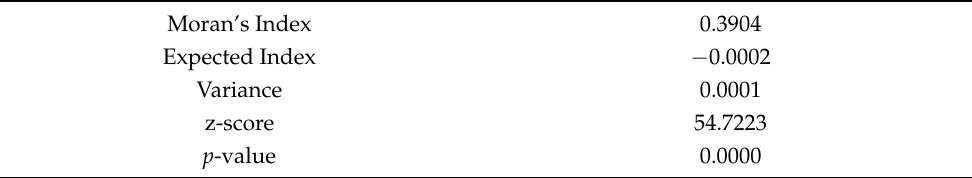
Table 5. Measures of spatial autocorrelation for the dwelling prices.